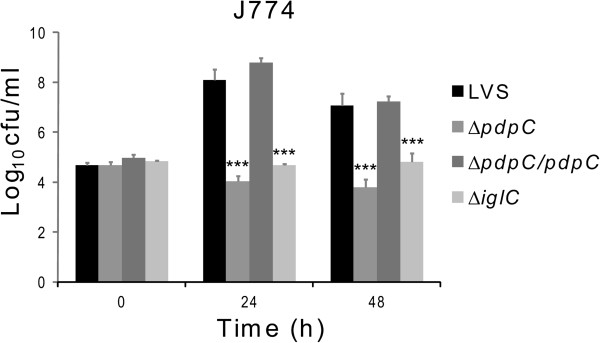
Intracellular growth of F. tularensis in J774 cells. LVS, the ΔpdpC mutant, the complemented ΔpdpC mutant, or the ΔiglC mutant was used to infect J774 cells for 2 h, after which the monolayers were washed and medium added (corresponds to 0 h). Cells were then incubated for 24 or 48 h before being lysed, serially diluted and plated to estimate the number of CFU. The graph presents a representative experiment out of eight performed. Each bar represents the mean value and the error bars represent the standard deviation. The asterisk indicates that the log10 data differs significantly from LVS (***: P < 0.001). Two-sided Student’s t-test was used to compare means.